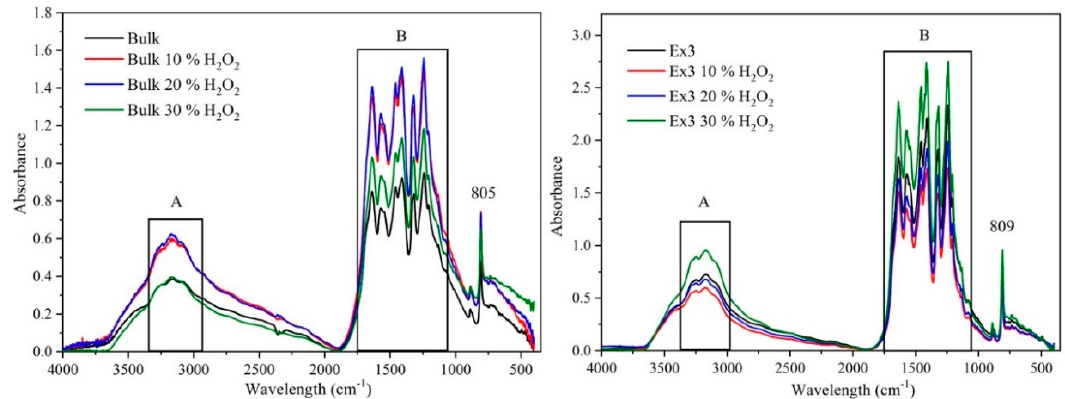
Figure 4. Fourier transform infrared (FTIR) spectra of bulk ( left ) and exfoliated GCN nanomaterials ( right